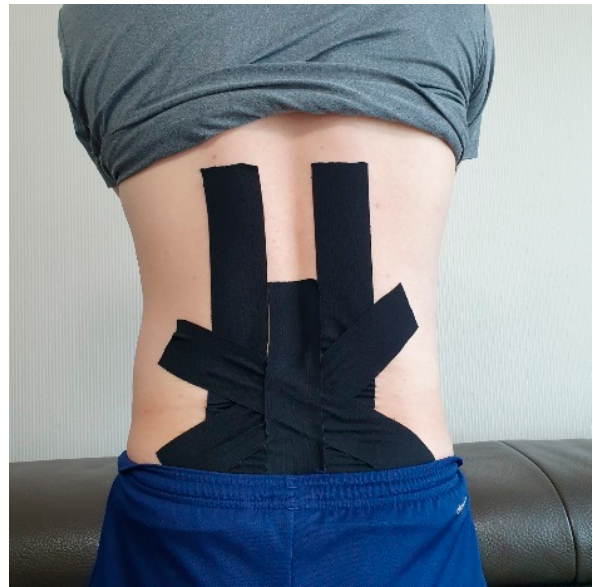
Figure 1. Taping application in CSET group.